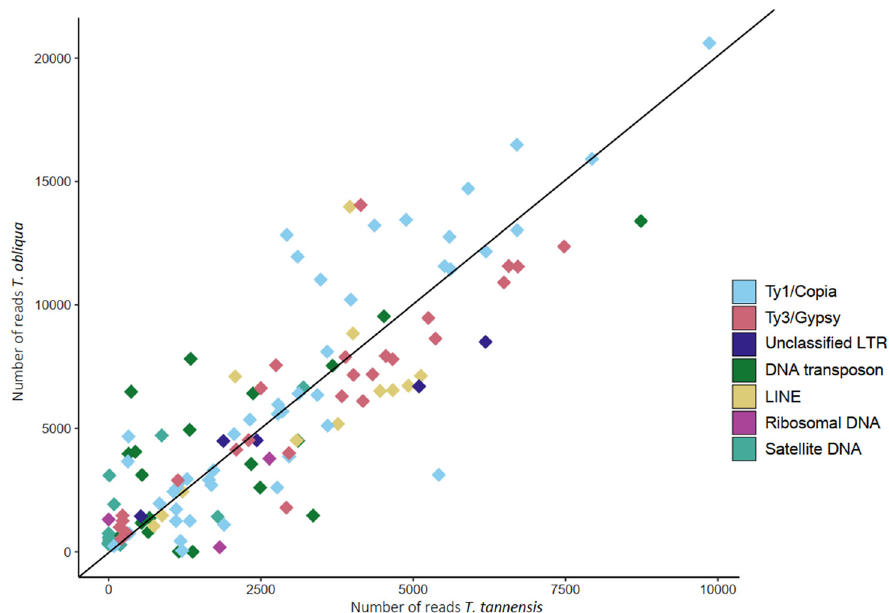
Figure 2. Pairwise scatterplot of the number of reads from shared repeat clusters from the comparative analysis of the two species of Tmesipteris . The slope of the line is equal to the ratio of the GS of the two species (R = 2.01). Table 2. Regression analysis statistics for different datasets. Regression between number of reads from; (i) repeat clusters classified Ty1/Copia elements, (ii) repeat clusters classified as Ty3/Gypsy elements, (iii) all clusters identified, and (iv) all clusters classified by RepeatExplorer2. Repetitive Elements